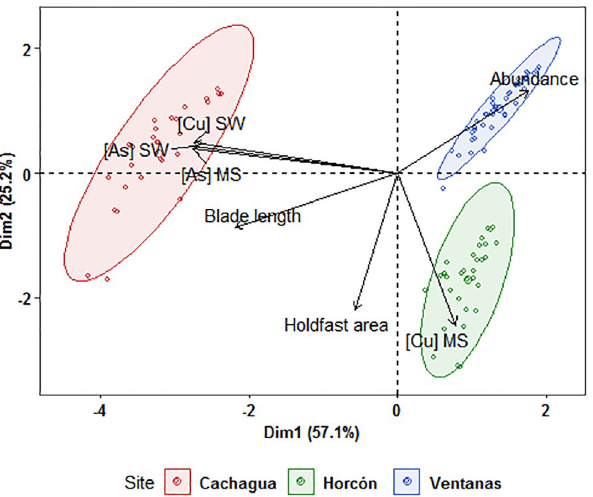
Fig 4. Principal components analysis of morphological features and heavy metals concentration. PCA includes abundance, holdfast area and blade length (Fig 2), plus the concentration of [As] and [Cu] in seawater (SW) and marine sediments (MS) (Tables 1 and